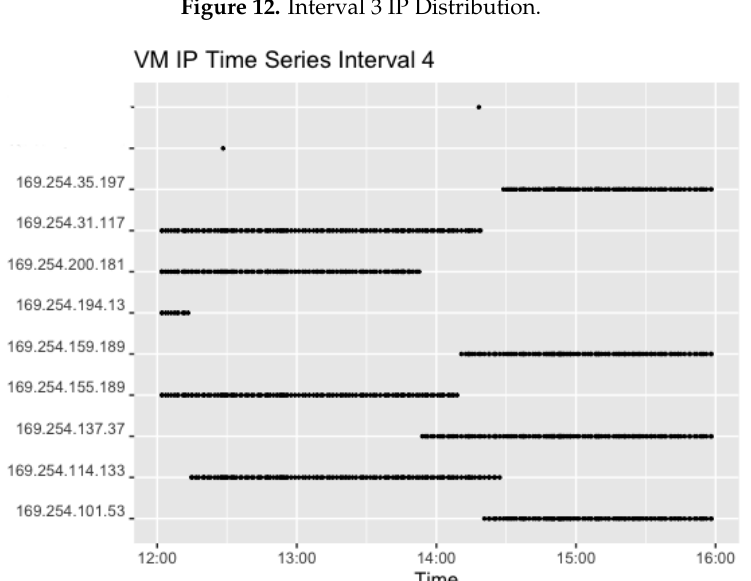
Figure 12. Interval 3 IP Distribution.